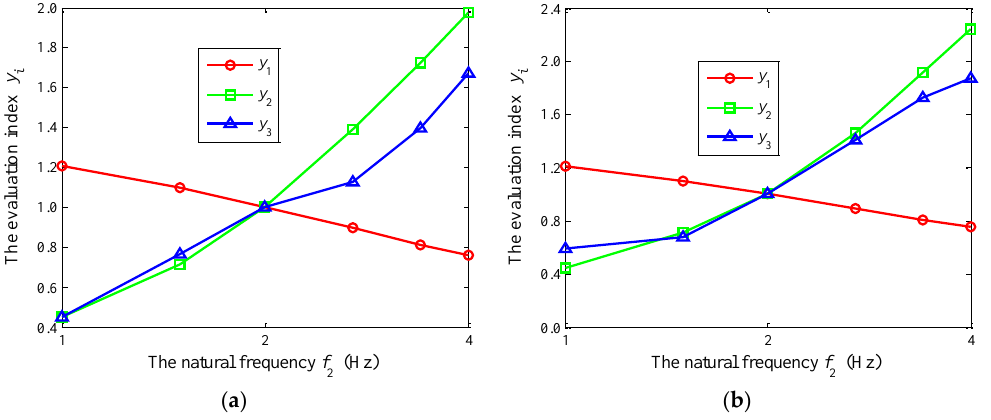
Figure 19. The evaluation index y i versus the natural frequency f 2 for the wheelchair: ( a ) going up the step; ( b ) going down the step.